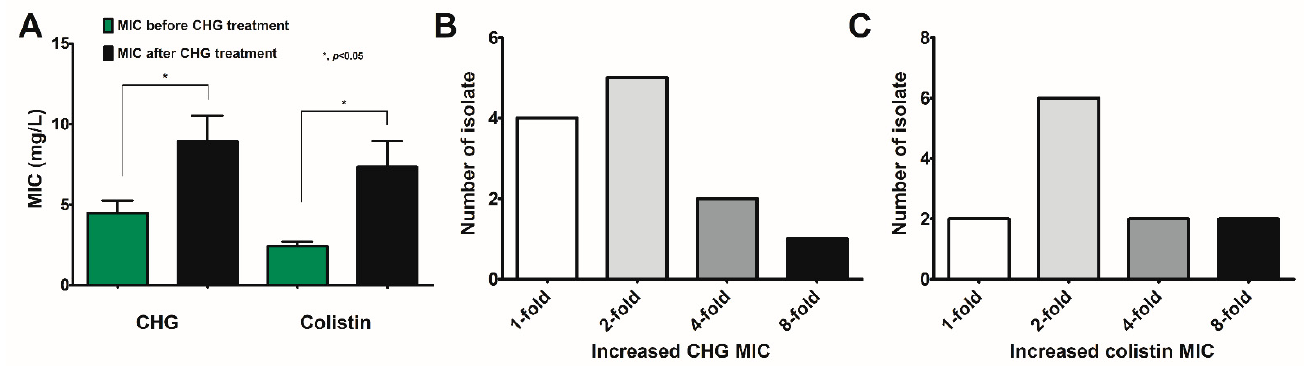
Figure 11. Chlorhexidine (CHG) treatment in other 12 clinical isolates of P. aeruginosa . Minimal inhibitory concentrations (MICs) of CHG-treated strains toward CHG and colistin using broth microdilution method ( A ) and the distribution of strains with increased MICs against CHG and colistin are demonstrated ( B , C ). Mean ± SEM are presented with the unpaired t -test (*, p < 0.05 considered statistically significant).